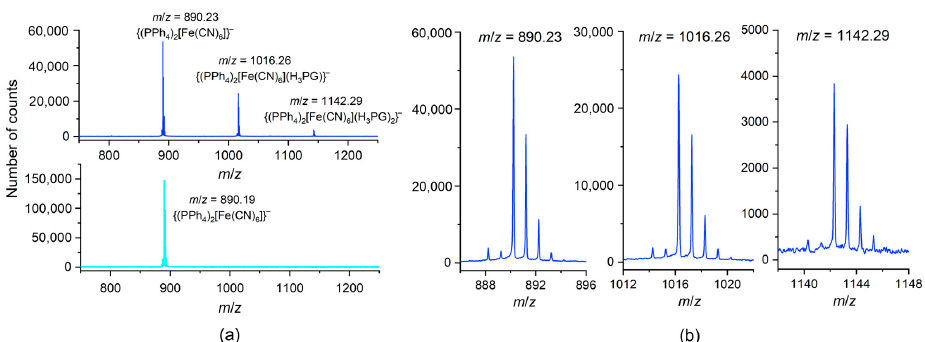
Figure 4. The ESI–MS spectra in the negative ionization mode for 2 (blue) and for (PPh 4 ) 3 [Fe(CN) 6 ] · 6H 2 O (cyan) as a reference: ( a ) the m / z range of 750 – –1250 – showing the peak-sets assigned to {(PPh 4 ) 2 [M(CN) 6 ]} – , {(PPh 4 ) 2 [M(CN) 6 ](H 3 PG)} – , and {(PPh 4 ) 2 [Fe(CN) 6 ](H 3 PG) 2 } –